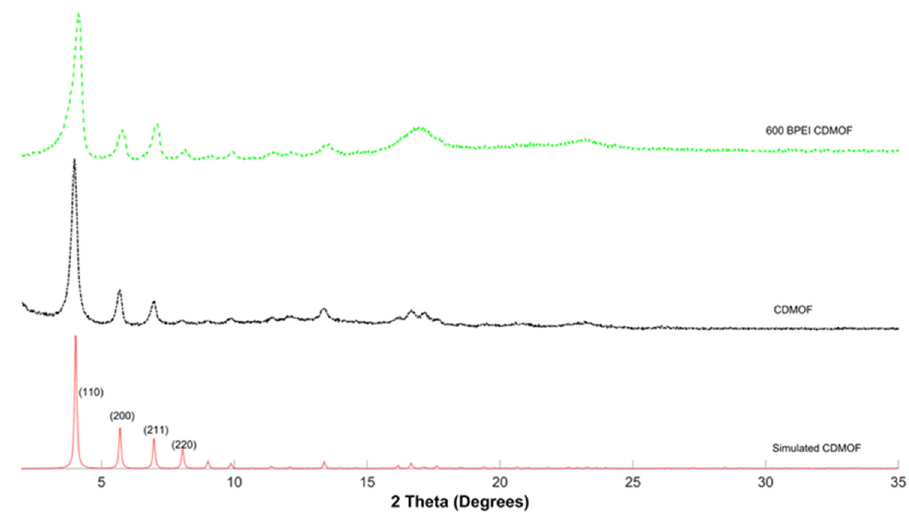
Figure 7. XRD data for simulated cyclodextrin MOF as well as control γ -CD-MOFs and 600 bPEI- γ -CD-MOFs .